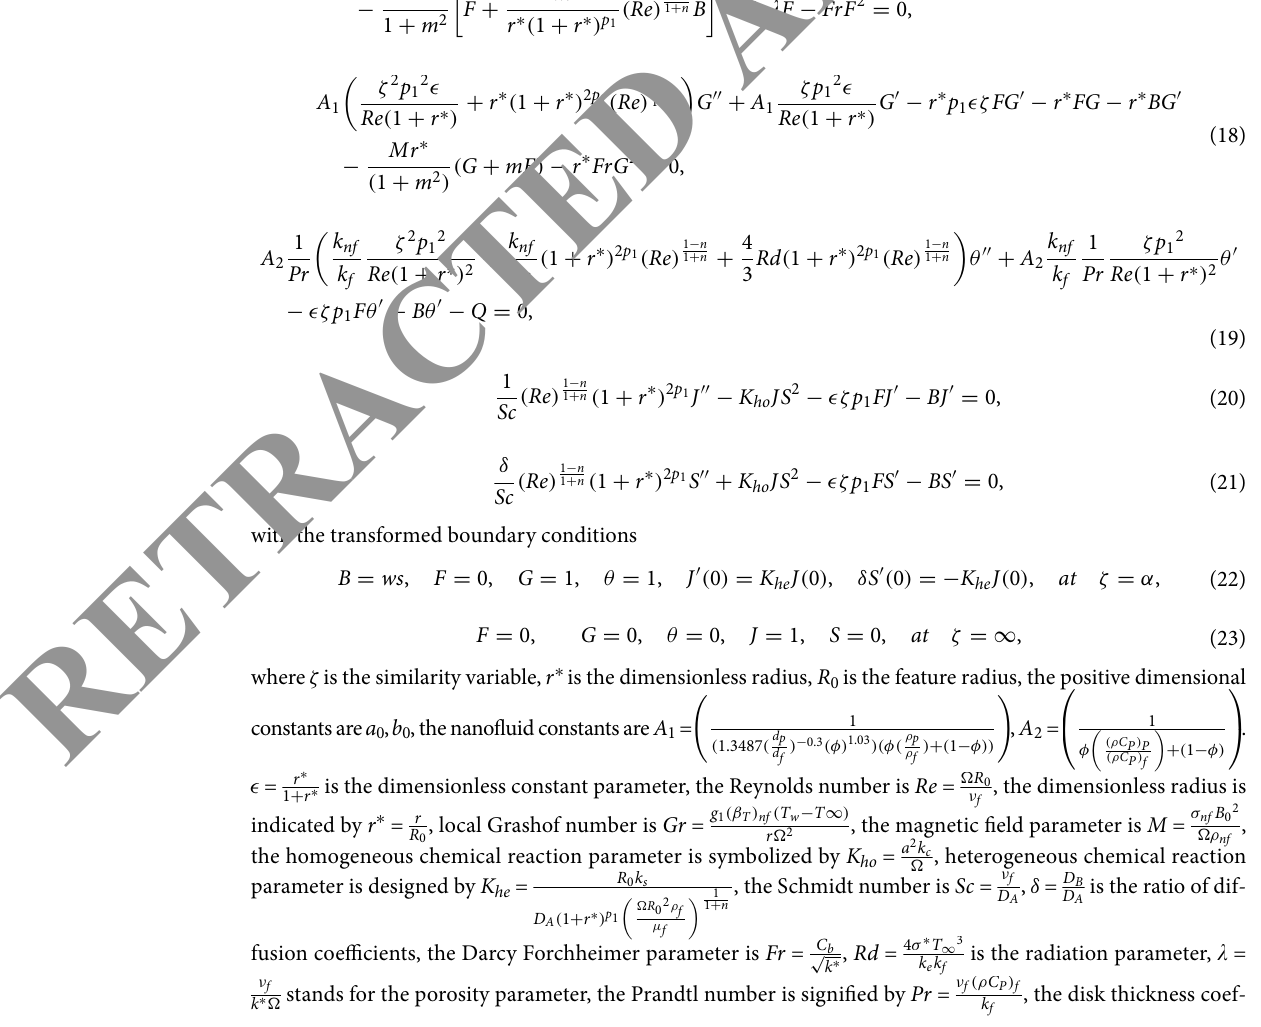
With the help of similarity transformations in Eq. (15), the obtained dimensionless governing equations are